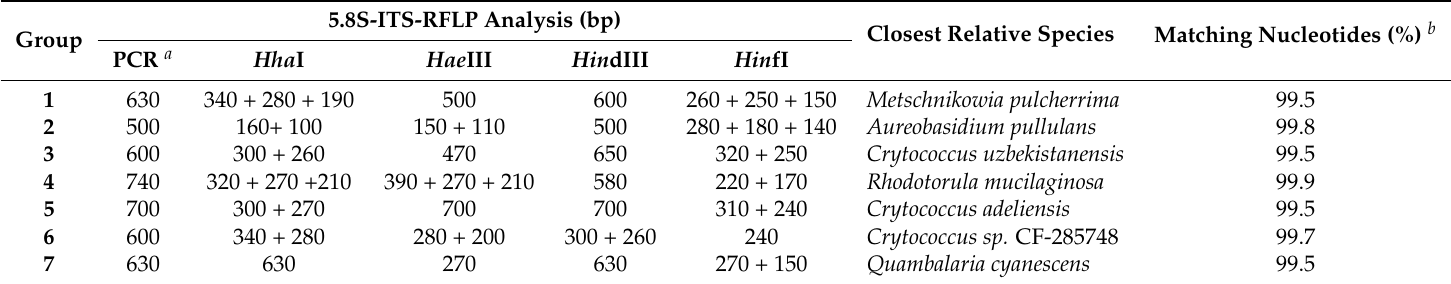
Table 4. Restriction analysis of the 5.8S-ITS PCR products and sequence information for the D1/D2 domains of 26S rDNA gene of groups of isolates.